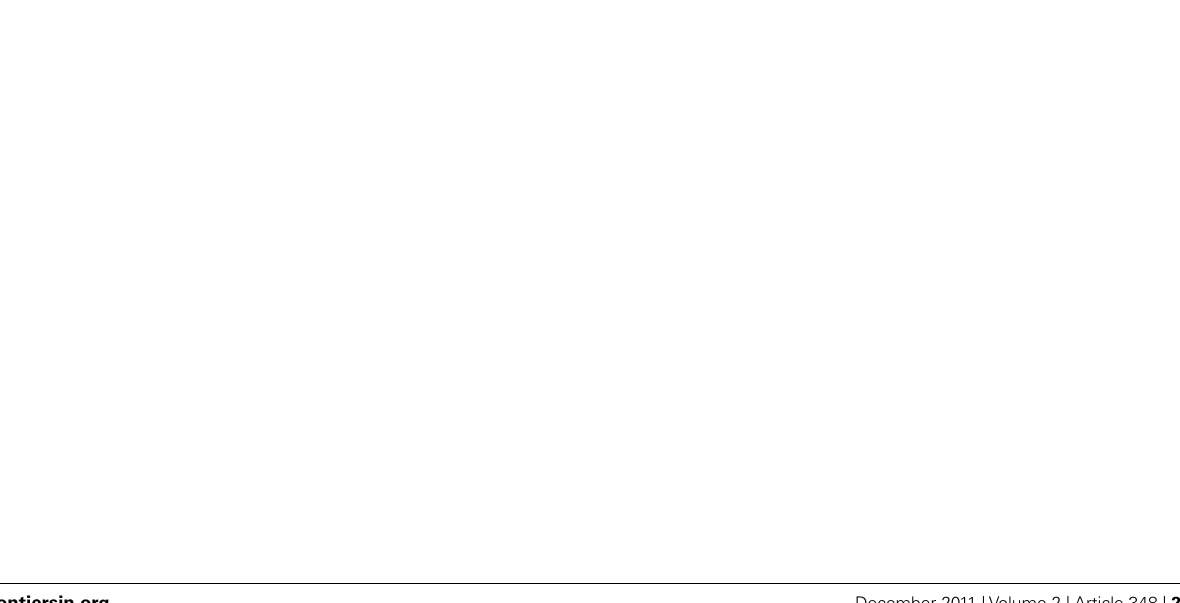
FIGUREA5 | Snapshots of the delay-line when (A) Implic decides to move the buffer to Prop after it has processed the first three constituent representations of the key-distractor; (B) buffer actually moves after a delay of 200ms; (C) Prop decides to move the buffer back to Implic after